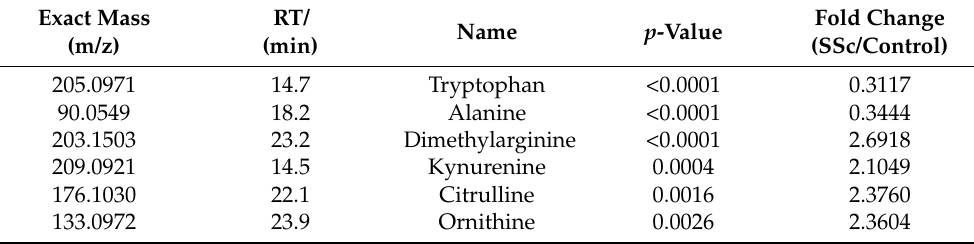
Table 1. Significantly changed metabolites identified by targeted metabolomics. Mass to charge ratio (m/z), retention time (RT), p -value (determined by a two-tailed Student’s t -test), and fold change (ratio of SSc to